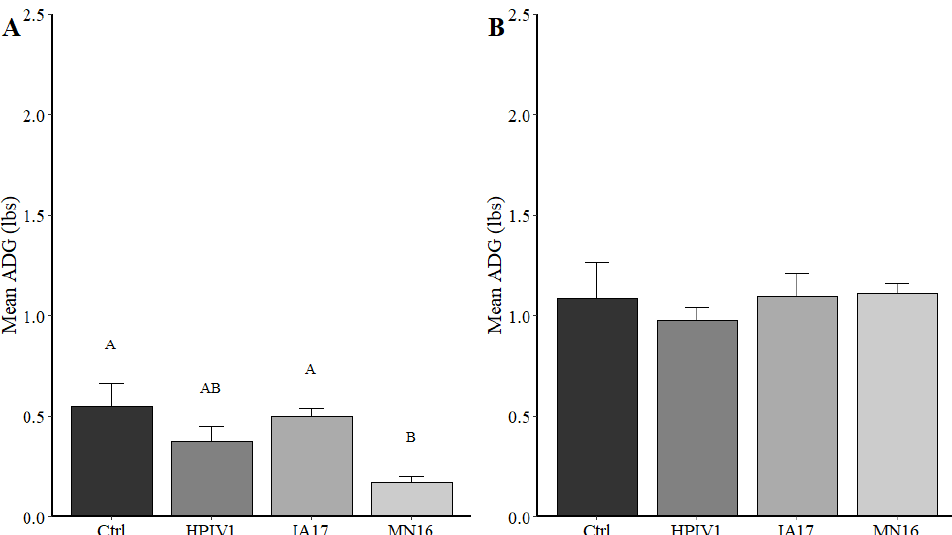
Figure 2. Mean average daily gain reported from the Ctrl, HPIV1, IA17 and MN16 groups. ( A ) Average daily gain measured at 5 DPI. Weight gain was significantly reduced in the MN16 group relative to the IA17 and Ctrl group. Different letters above the bar in the graph indicates a significant difference ( p < 0.05) between experimental groups. ( B ) Average daily gain measured at 28 DPI. No significant differences were observed in average daily gain between any groups. Ctrl: Control group; HIPV1: Human parainfluenza virus 1; IA17: USA/IA84915LG/2017; MN16: